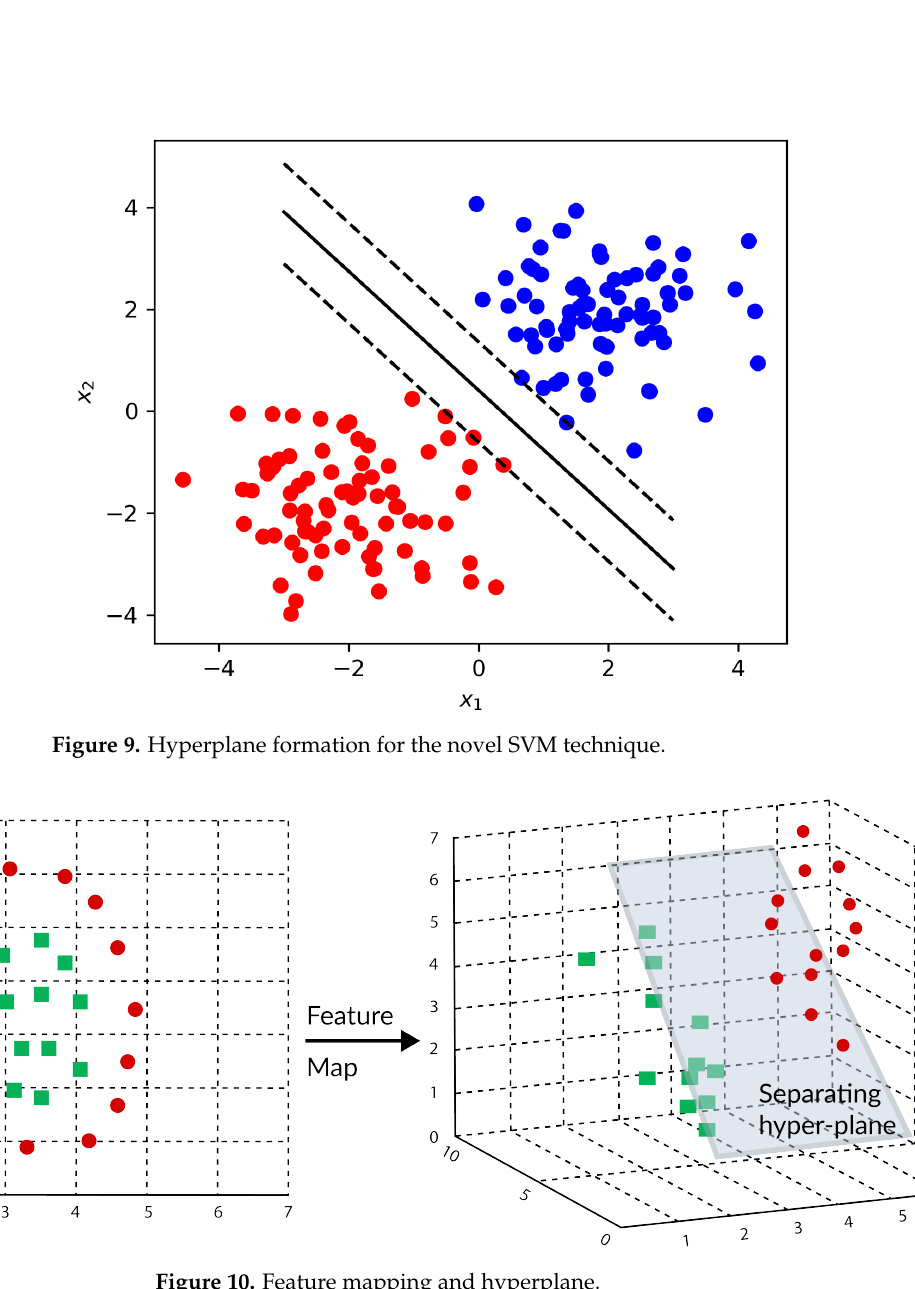
Figure 10. Feature mapping and